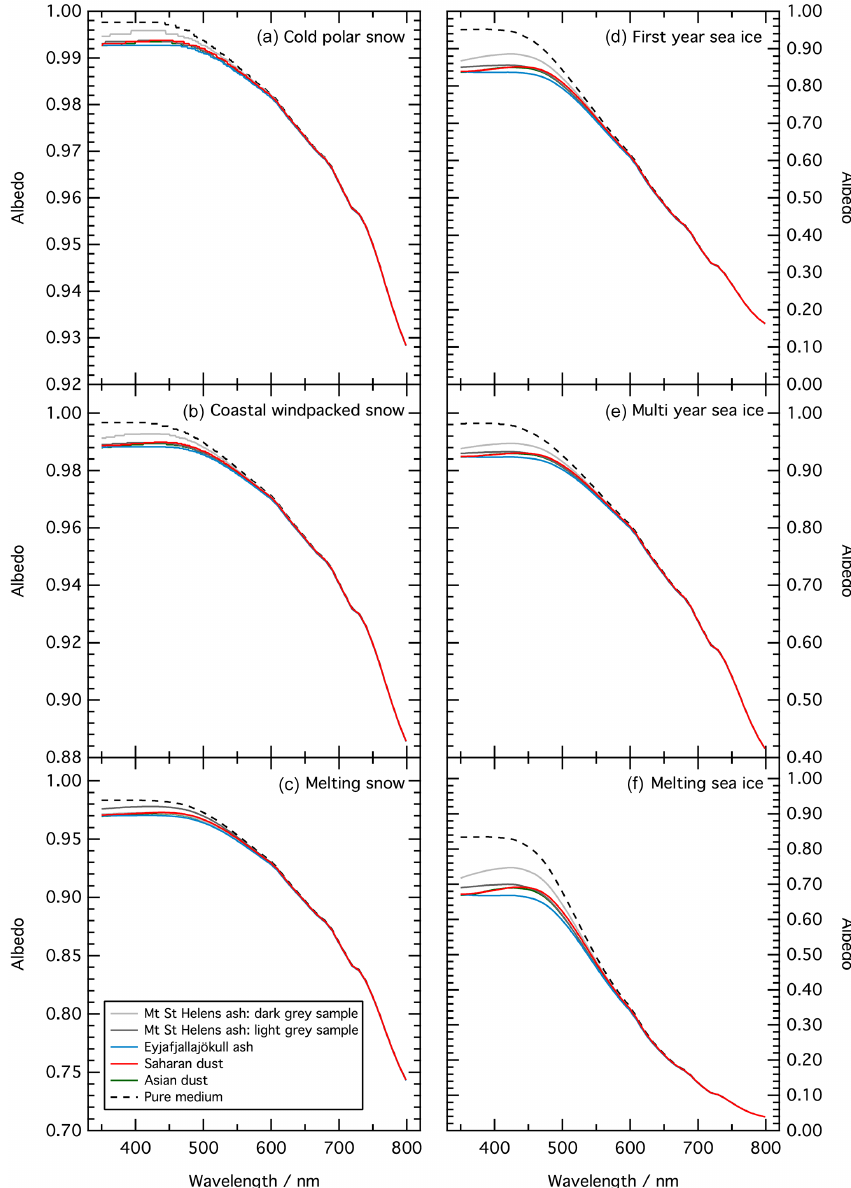
Figure 4. Wavelength-dependant albedo of three semi-infinite snow and sea ice types containing 100ngg − 1 of different mineral aerosol deposits (Mt St Helens ash, Eyjafjallajökull ash, Saharan dust and Asian dust). The albedo of a pure medium (containing 1ngg − 1 of Asian dust) has been included for comparison. The y axis has different scales in each panel to cover the large range of